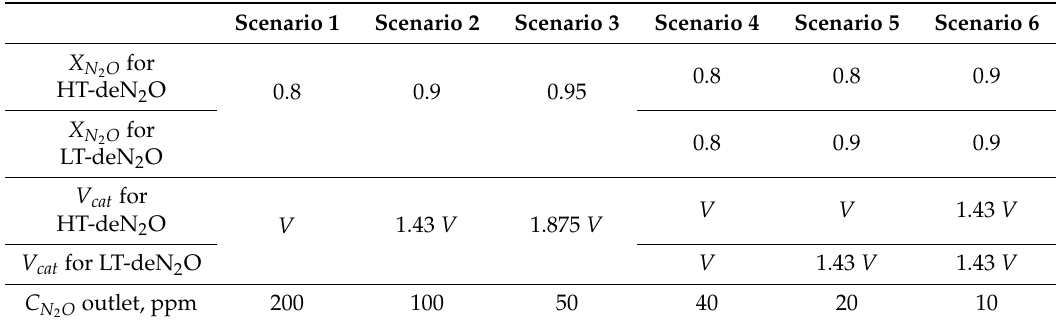
Table 1. The comparison of nitrous oxide emission, expressed as N 2 O concentration at the end of technological line (in the chimney) for combination of di ff erent deN 2 O variants. Assumed primary N 2 O concentration in nitrous gas after ammonia oxidation reaction zone equals to 1000